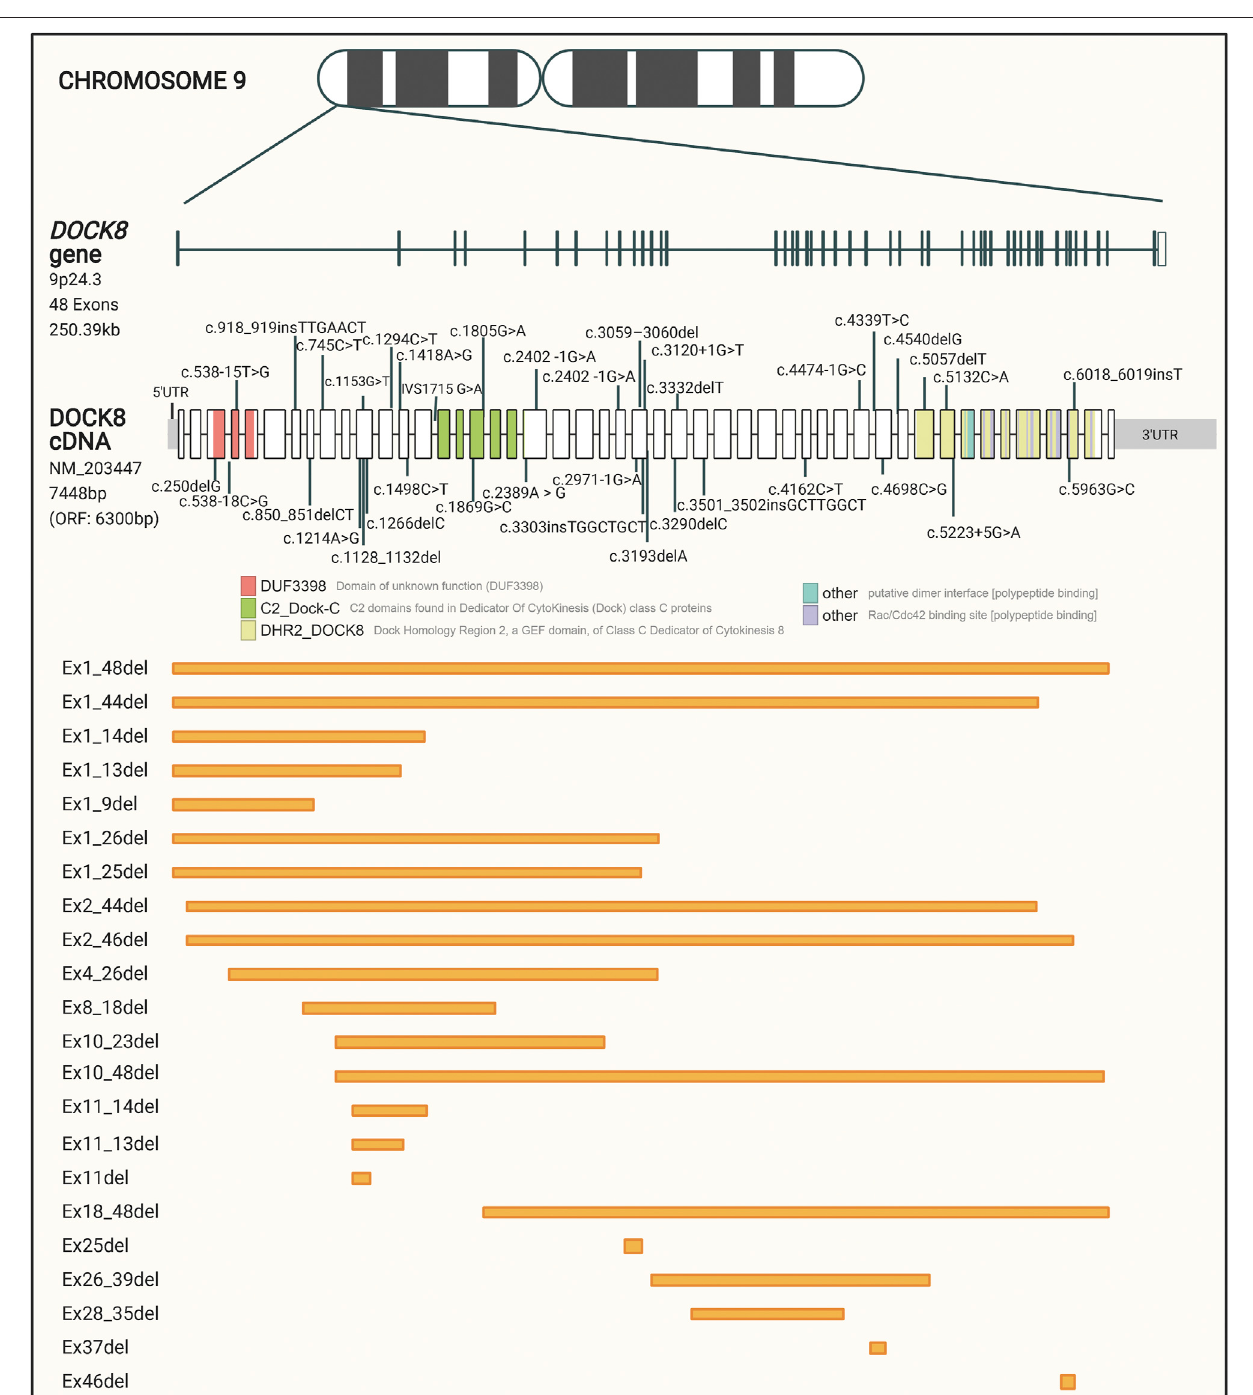
FIGURE 1 | Schematic representation of reported patient mutations in the DOCK8 gene. The DOCK8 gene, composed of 48 exons, islocated on the short arm of chromosomenineandspansover250 kb.ThedistributionofmutationsassociatedwithDOCK8de fi ciencycollectedfromtheClinVardatabaseisrepresentedalongthe DOCK8cDNA. Boxes represent the48 exonsofthe geneand differentcolors indicate major domain-encodingregions. Outofatotal of1,139 DOCK8 variants reported to date, 60 have been found in patients where DOCK8 de fi ciency has been diagnosed. Orange boxes represent deletions of one or more exons.